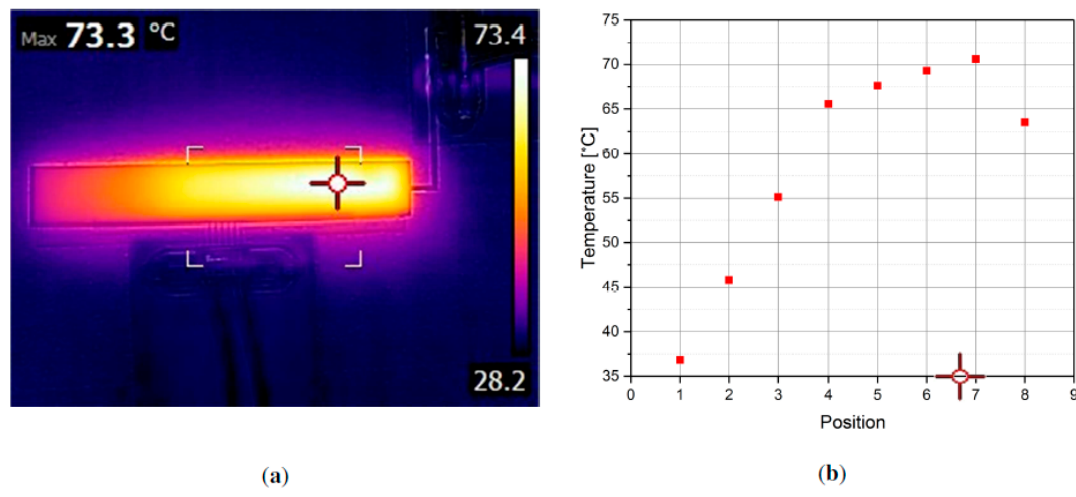
Figure 4. A plastic bar heated on one side was placed on the thermocouple array and the temperature gradient was measured with an infrared camera and the thermocouple array; ( a ) Thermal image of a heated bar recorded with an infrared camera; ( b ) Measured temperatures of the bar recorded with the thermocouple